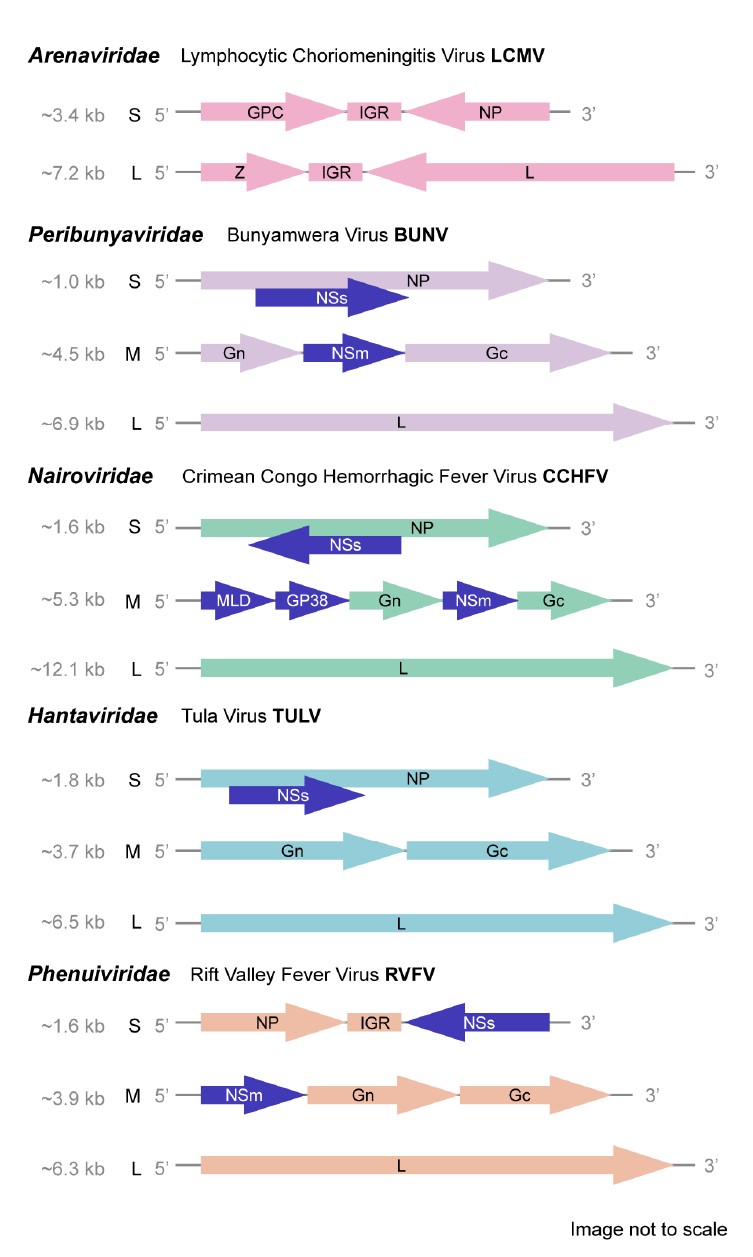
Figure 3. Bunyavirales Genome Organization. Specific genome structures for Bunyavirales families containing human pathogens, including Arenaviridae , Peribunyaviridae , Nairoviridae , Hantaviridae , and Phenuiviridae [5,12–19], are shown. The reference strain for each family is listed as well as the approximate size of each genomic segment. Glycoprotein precursor (GPC), nucleoprotein (NP), intergenic region (IGR), zinc-binding matrix protein (Z), non-structural S segment protein (NSs), non- structural M segment protein (NSm), surface glycoproteins (Gn and Gc), mucin-like domain (MLD), and secreted glycoprotein (GP38). NS proteins are highlighted in dark blue and include NSs and NSm, along with MLD and GP38 for Nairoviridae . The L segment is not as well understood as S and M and has many regions with unknown function but, across the order encodes the RNA-dependent RNA-polymerase (RdRp) gene.